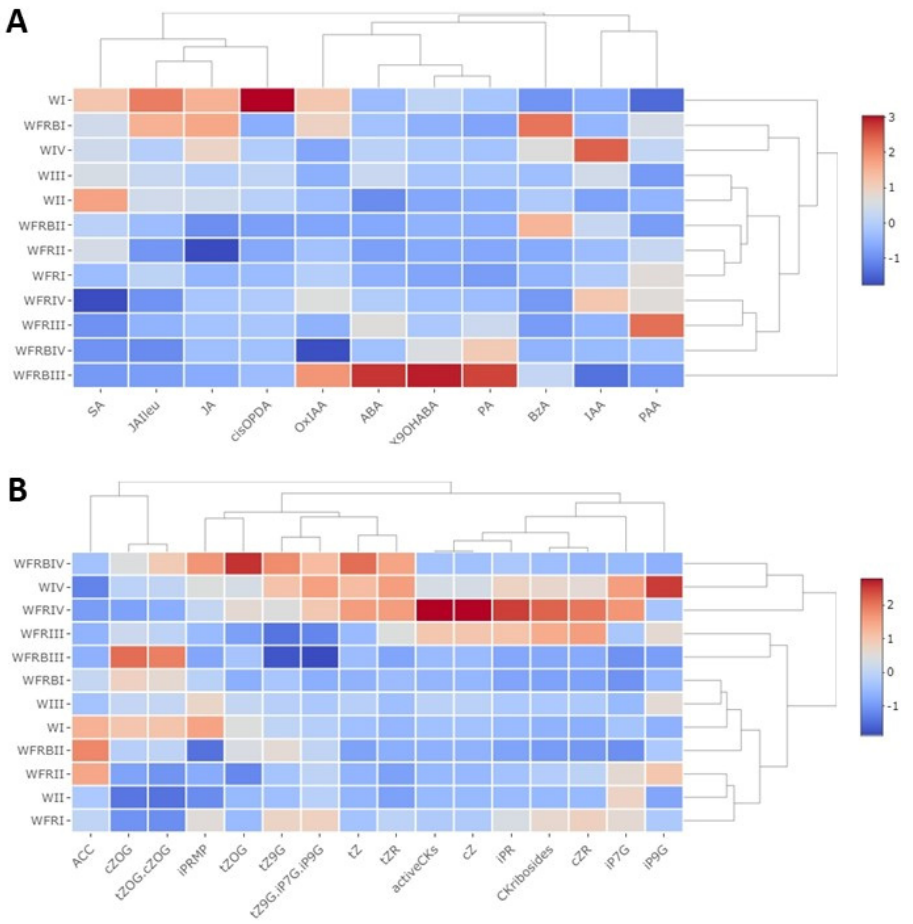
Figure 2. The effect of supplementary FR and Blue light at normal and low temperature on hor- mone concentrations. Leaf samples were collected six to eight hours after the start of illumination. The plantlets were grown under a 12 h photoperiod. ( A ) fraction A, eluted with methanol containing ABA, IAA, SA, and JA; ( B ) fraction B, eluted with 0.35 M NH4OH in 60% methanol containing CKs. W: white light, WFR: far-red-enriched white light, WFRB: far-red and blue-enriched white light. I − 1 day at 15 ◦ C, II − 10 days at 15 ◦ C, III − 1 day at 5 ◦ C, IV − 15 days at 5 ◦ C. The data originated from three to five biological replicates. The values on the X and Y axis outside of the heat map refer to the distance or proximity of data after hierarchical